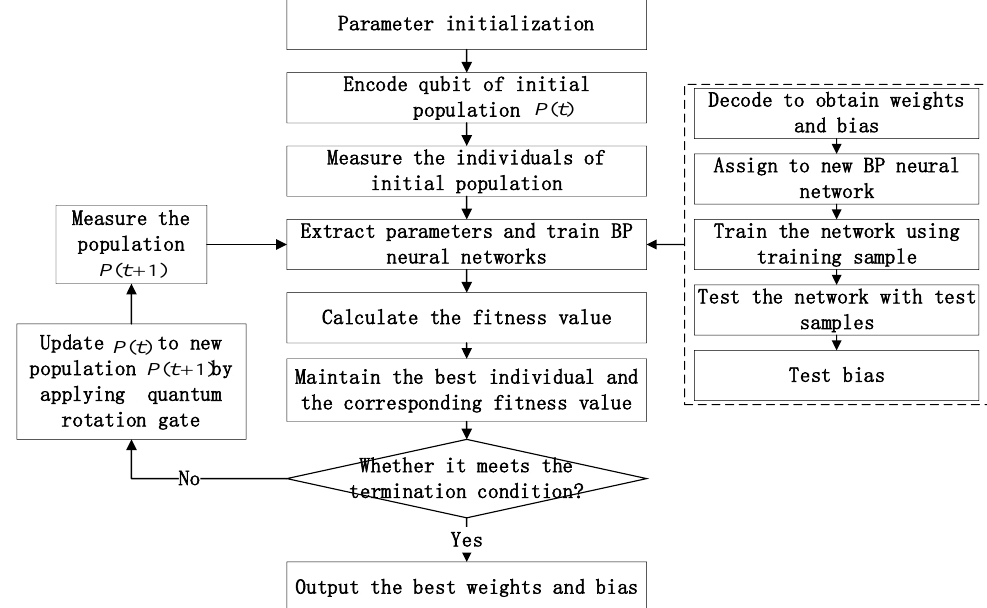
Aerospace 2022 , 9 , x FOR PEER REVIEW Figure 2. Optimization of a BP neural network by a quantum genetic algorithm. Figure 2. Optimization of a BP neural network by a quantum genetic algorithm.